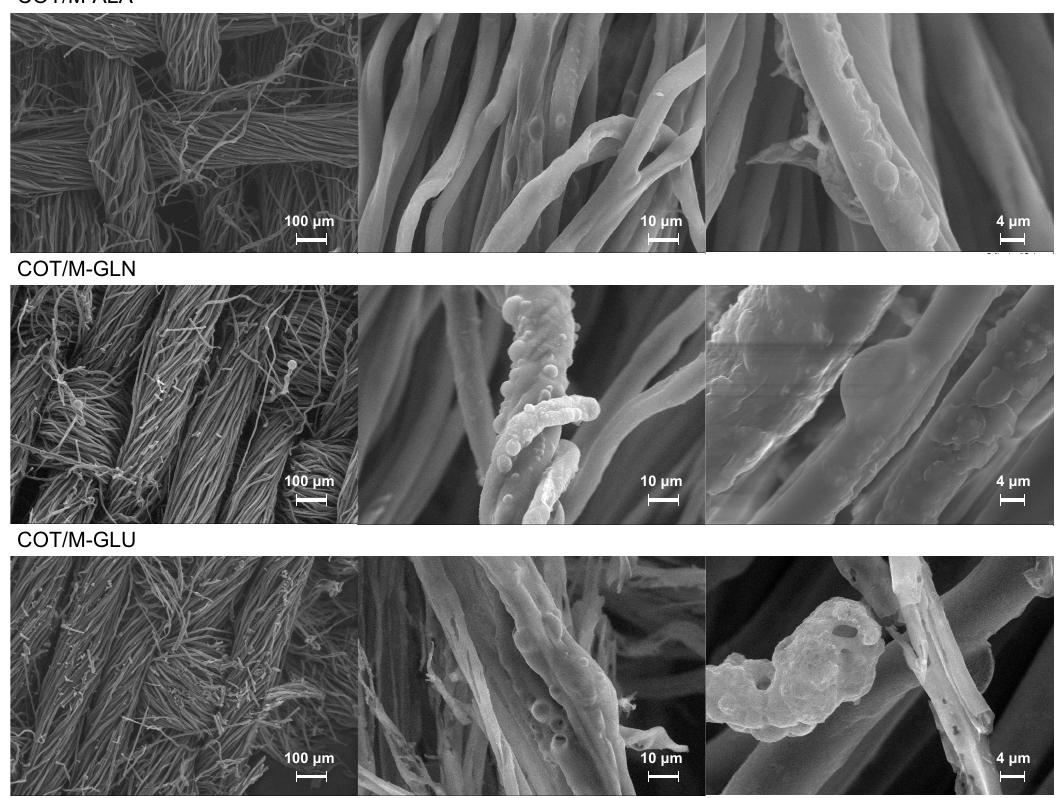
Figure 9. SEM micrographs of 7% add-on COT/MBA-ALA, COT/MBA-GLN and COT/MBA-GLU residues from HFSTs.